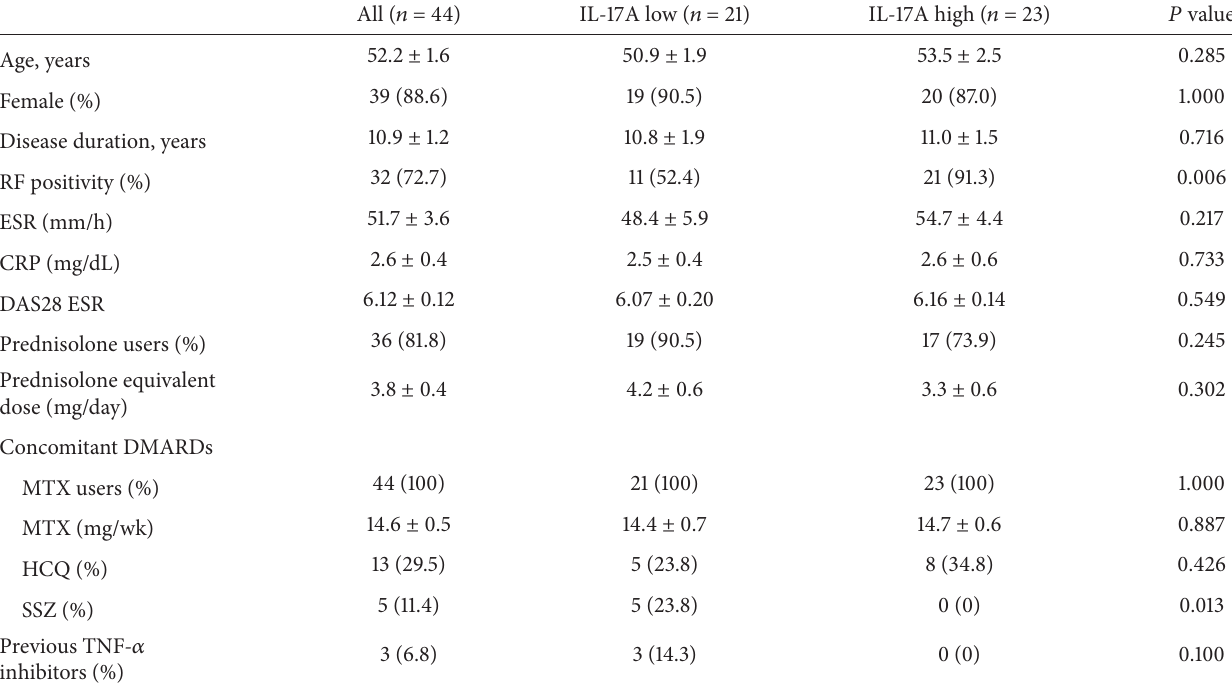
Table 1: Baseline clinical characteristics of the IL-17A low group and the IL-17A high